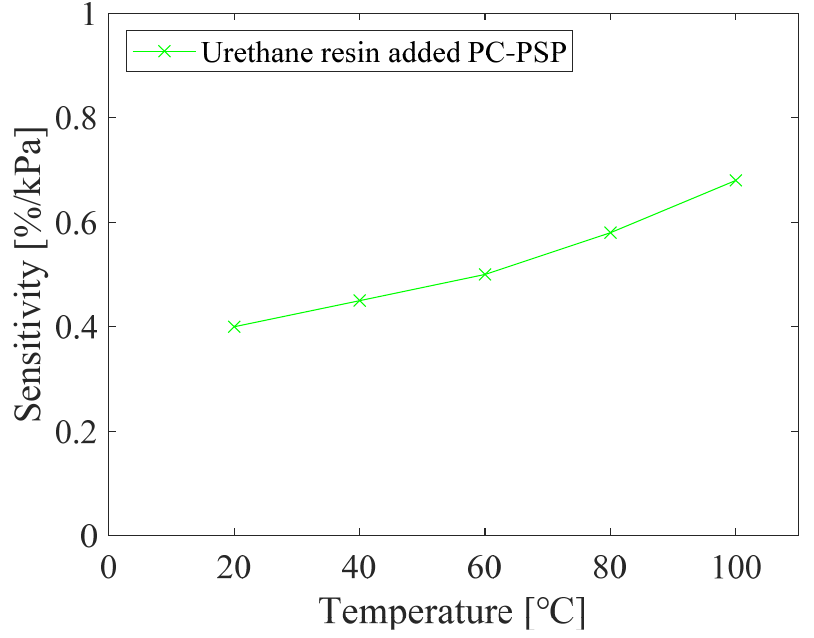
Figure 13. Pressure sensitivity of PC-PSP with 0.5 g of urethane resin at different temperatures.